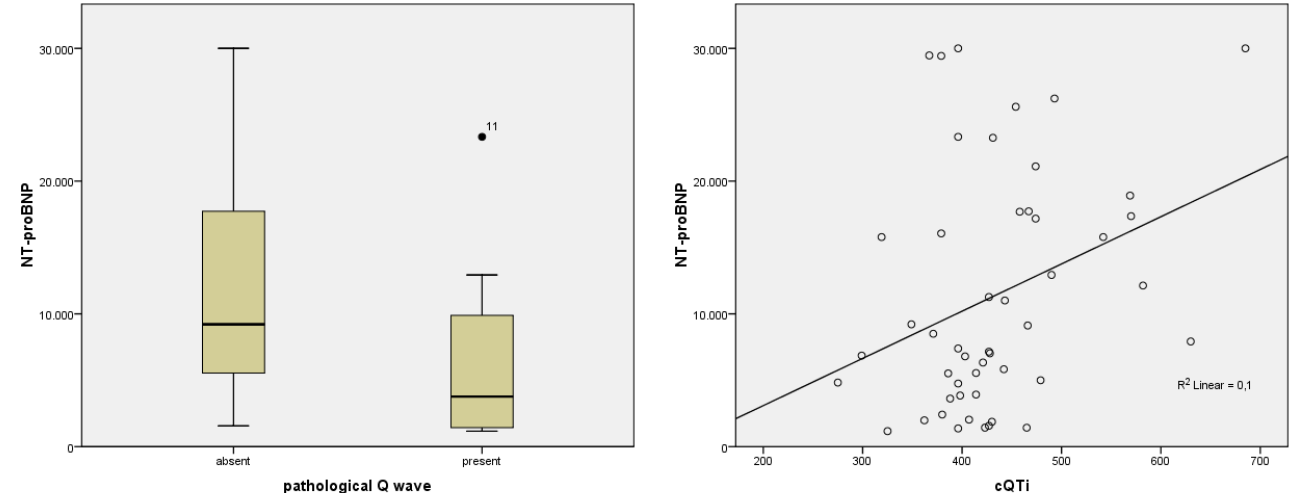
Figure 1. Correlations of NT-proBNP with cQTi and pathological Q wave in patients with AHF. Abbreviations: NT-proBNP = N-terminal (NT)-pro B-type natriuretic peptide; cQTi = corrected QT interval.